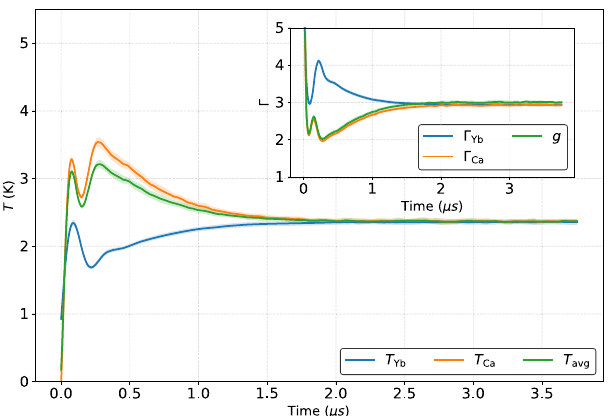
Fig. 2 Temperature evolution of Ca + /Yb + mixture. Data are from MD simulations with Ca + and Yb + densities of 4.3 × 10 9 and 1.3×10 10 cm − 3 , respectively. For this simulation κ = 0.395, T e = 100 K, n e = 1.73× 10 10 cm − 3 . T avg is calculated from Eq. (12), Γ Y b,Ca from Eq. (1), and g from Eq. (21). The oscillations in the temperature during the fi rst 0.5 μ s are kinetic energy oscillations initiated during the DIH process [see refs. 56 and 58 ].